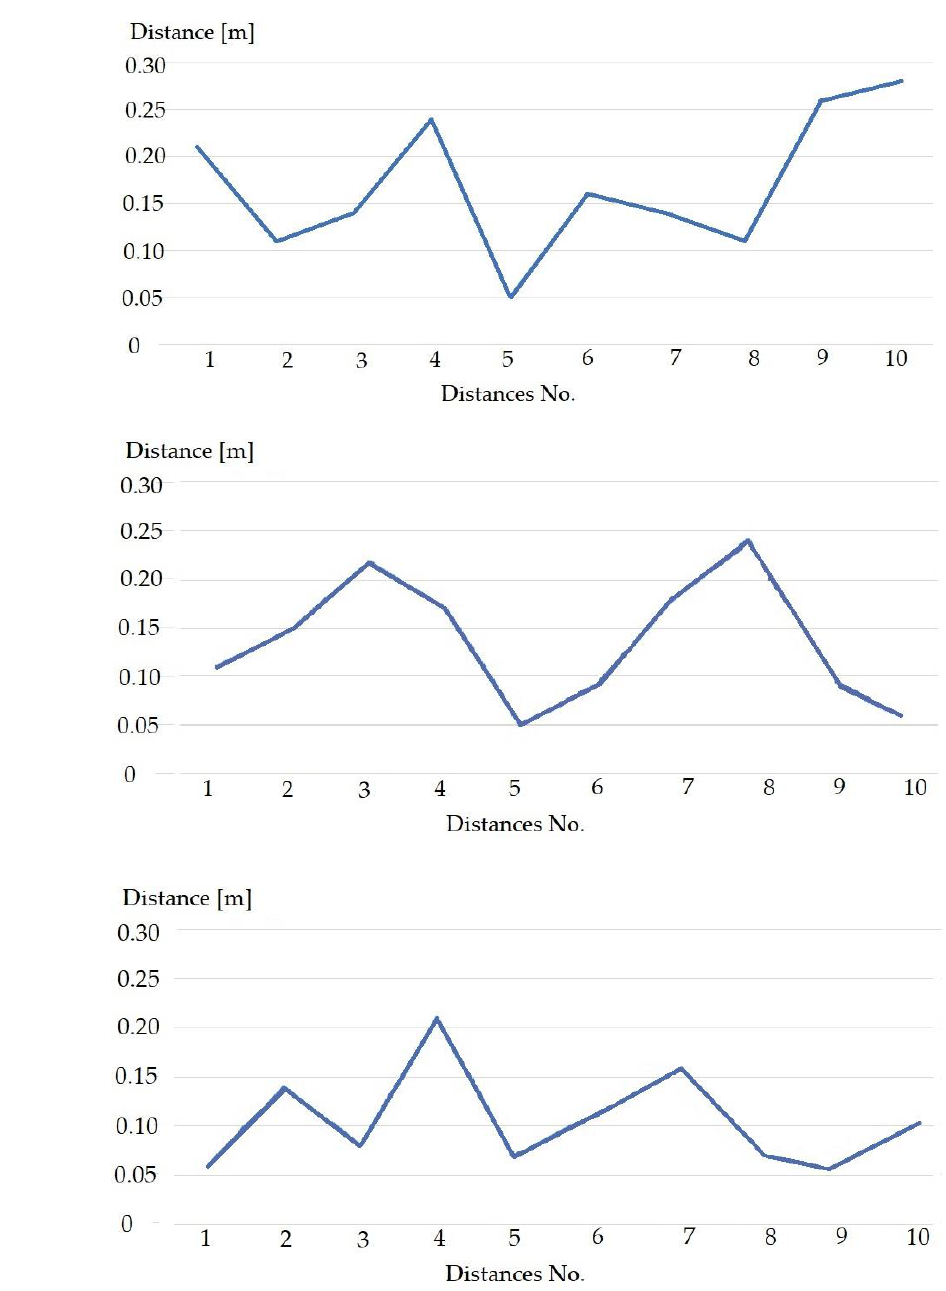
Figure 4. Comparison of results between point clouds, based on the distance between clearly identifiable